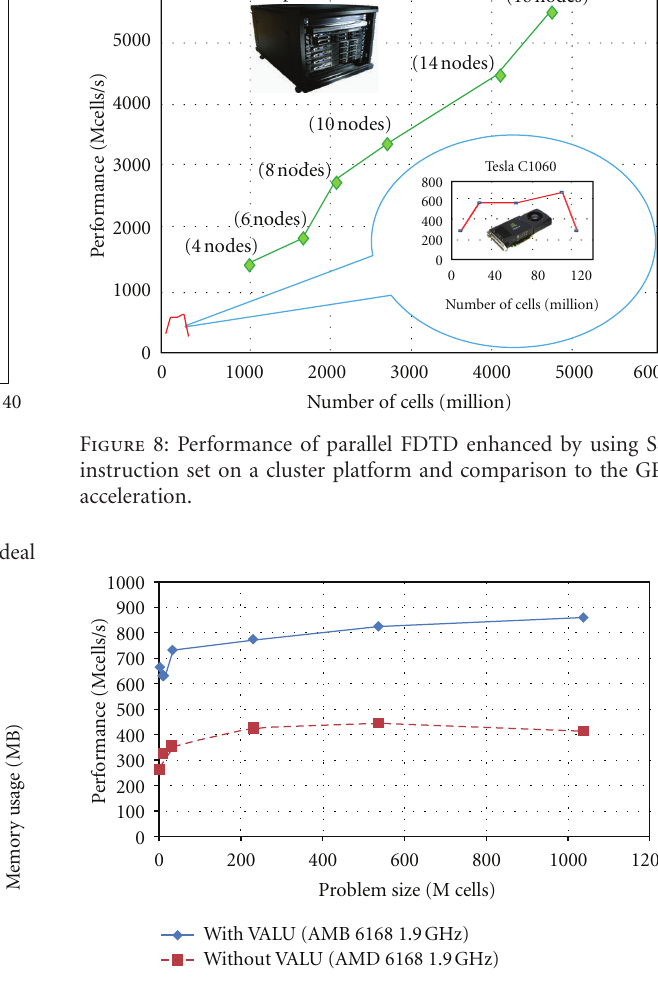
Figure 9: FDTD performance of the VALU acceleration on one 4- CPU workstation.